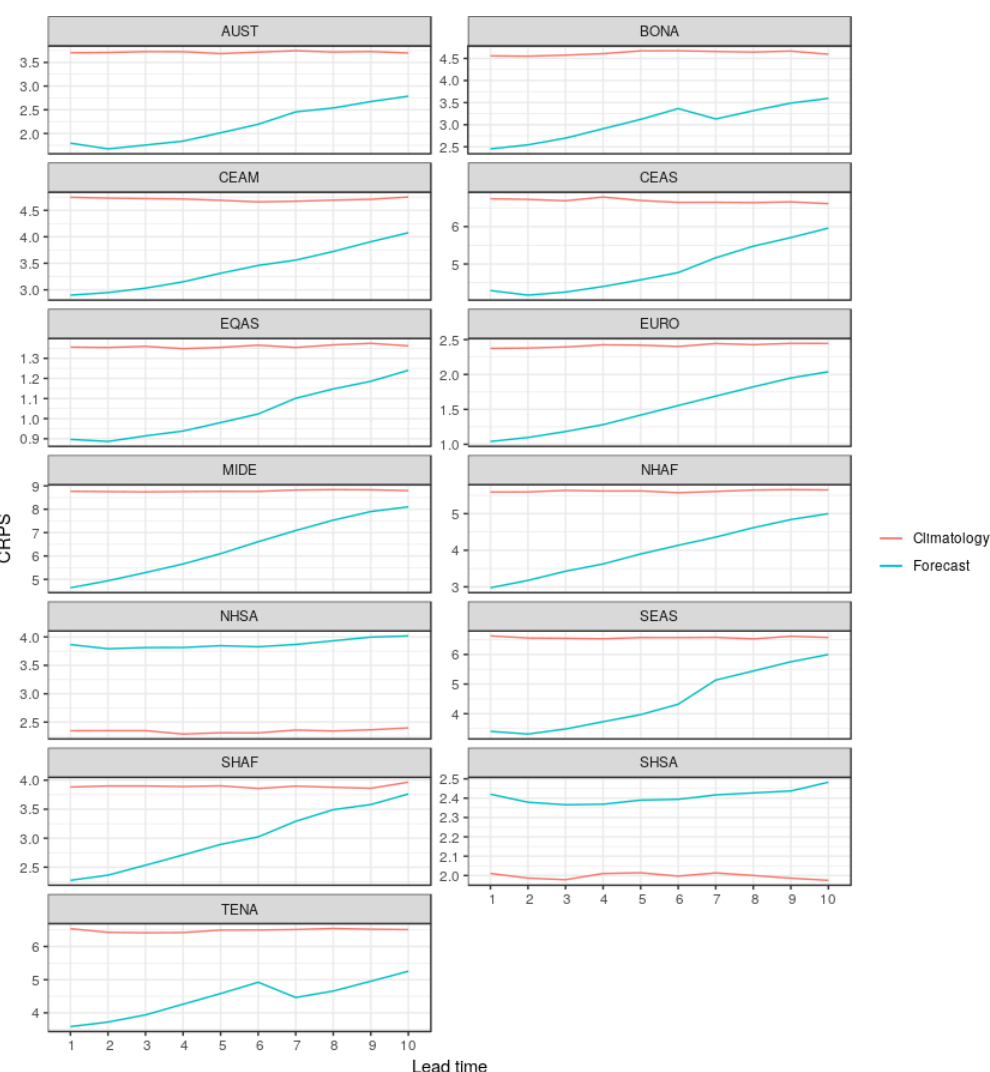
Figure 4. As Fig. 3 but with aggregation performed on the GFED